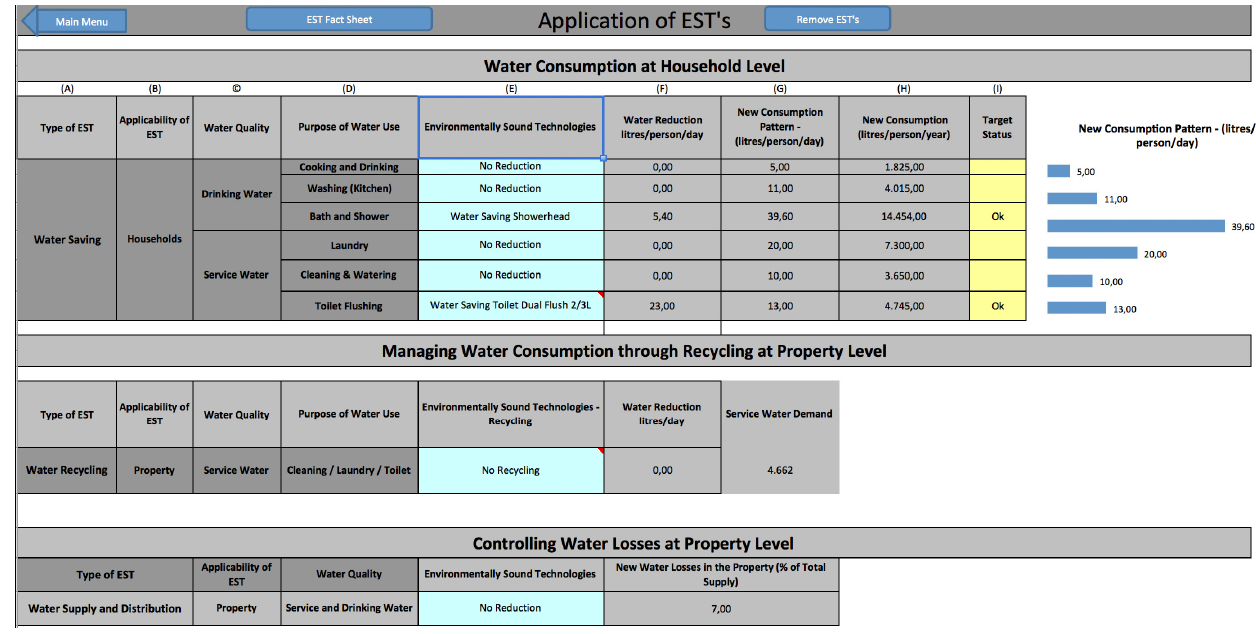
Figure 7. User interface of the “Water Consumption after environmentally sound technologies (EST)” sheet in “Wise Water”. By means of pull down menus in the blue marked cells, the user can choose from different options for reducing “Water Consumption at Household Level”, “Managing Water Consumption through Recycling at Property Level”, and “Controlling Water Losses at Property